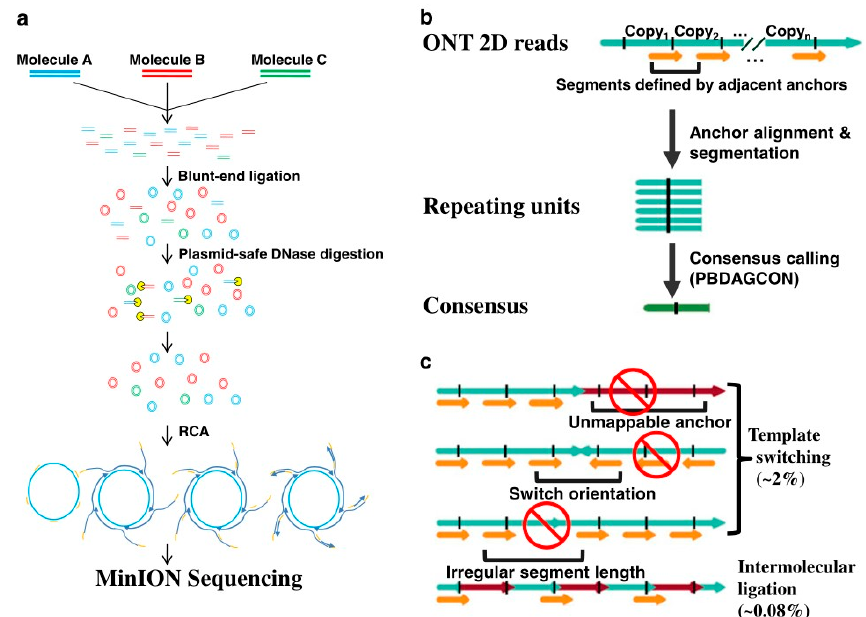
Figure 3. The schematics of INC-seq sequencing technology show ( a ) the process of making RCA, ( b) the process of locating the repeat sequence with anchor, and ( c ) the sources of chimeras [43]